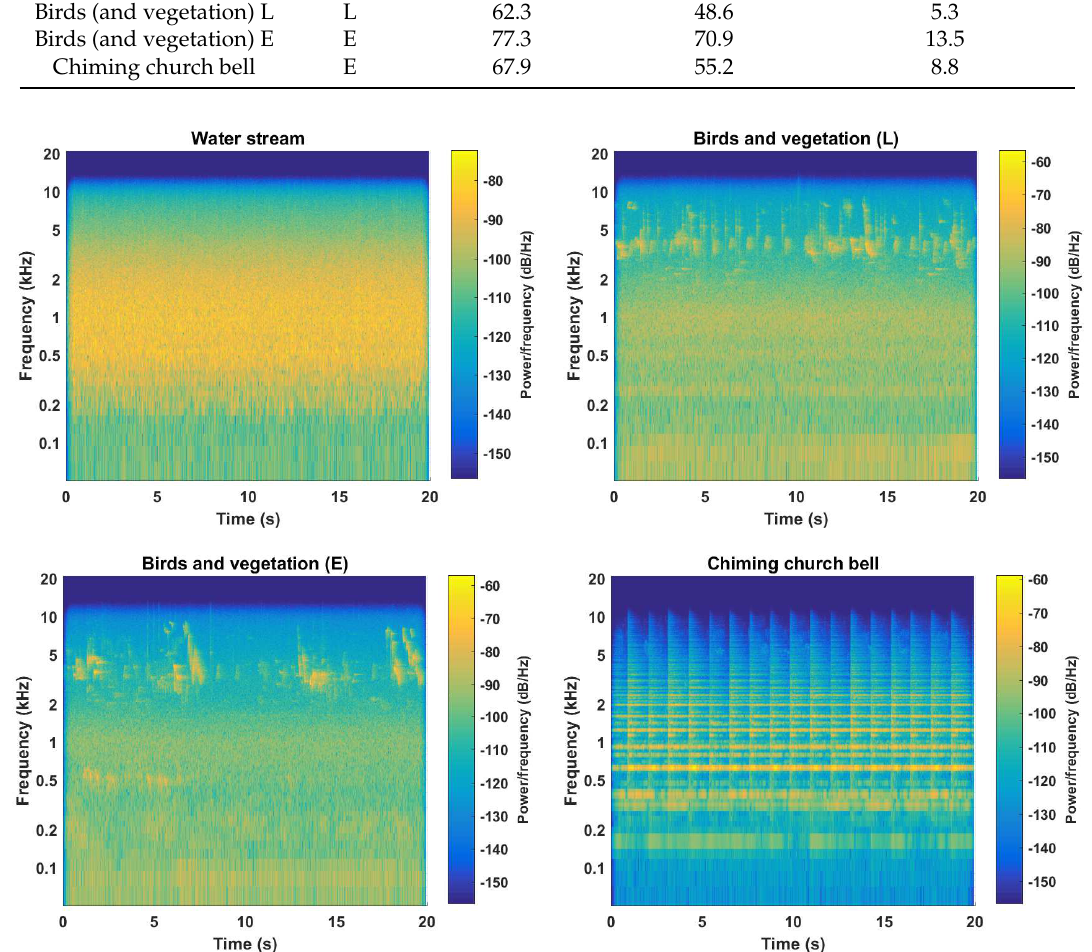
Figure 1. A-weighted spectrograms of the background signals. Hann-windows of 2048 samples (42.7 ms) with an overlap of 50% (1024 samples) were used to generate the spectrograms. For